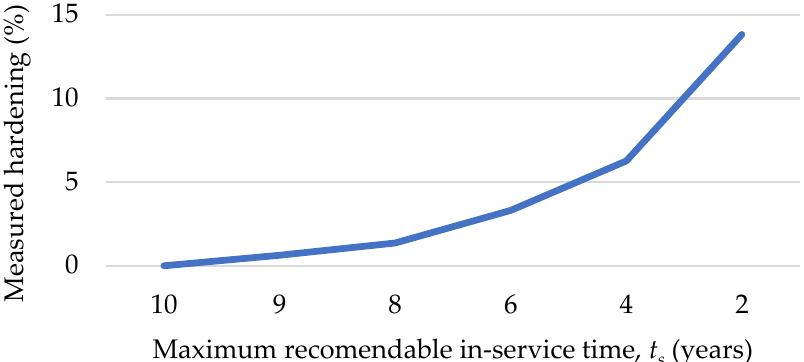
Figure 11. Maximum recommendable in-service time ( t s ) as a function of hardening (from hard- ness values).